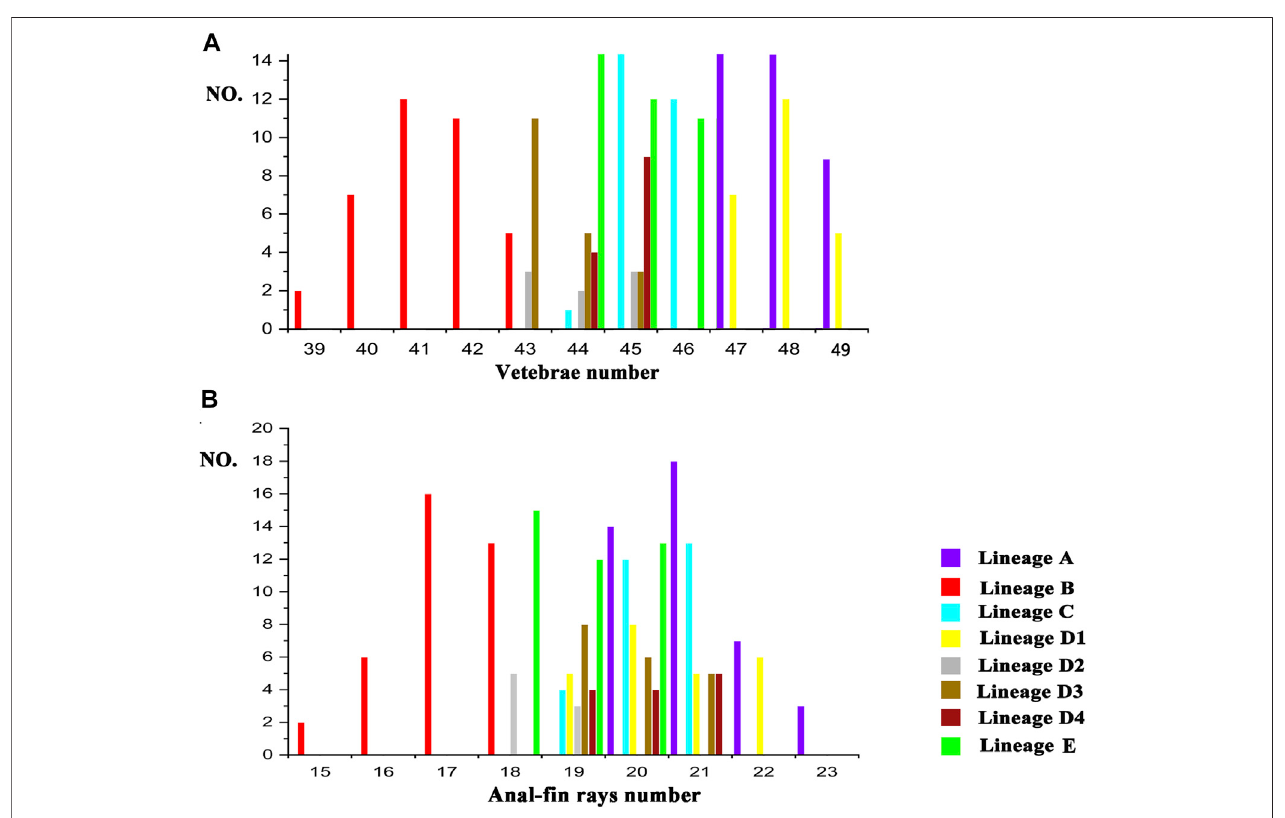
FIGURE 5 | Meristic counts difference among eight geographic populations in vertebrae number (A) and anal- fi n ray number (B) .